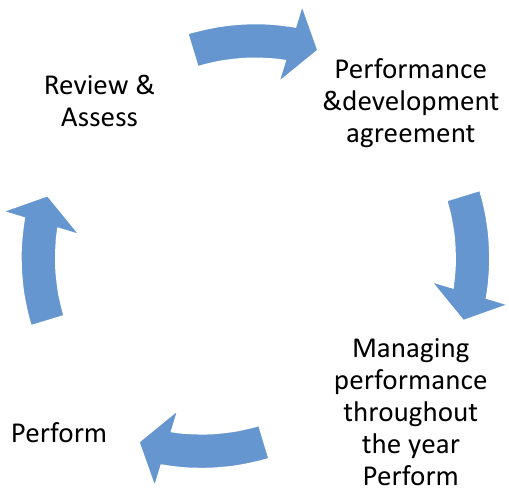
Source: Armstrong, 2006:639